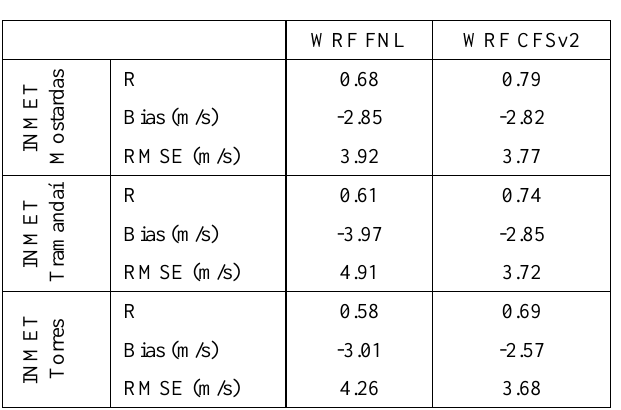
Table 2. Statistical metrics comparing the observed INMET stations wind speed with those simulated by the WRF model (FNL and